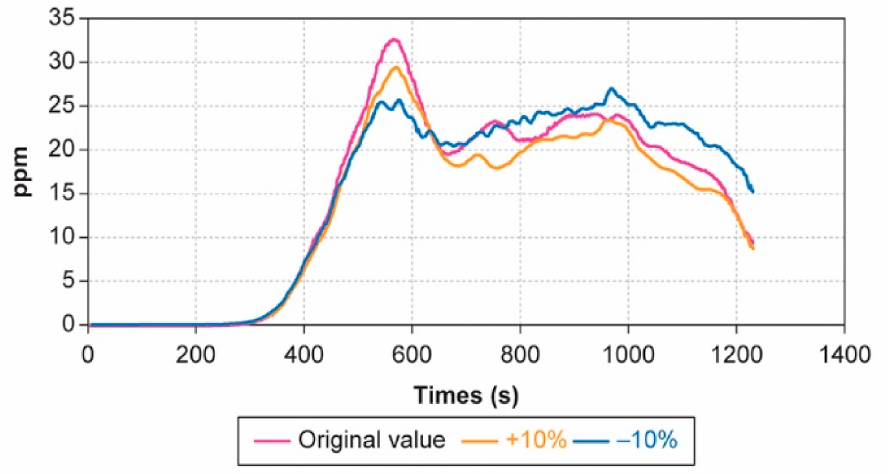
Figure 11. CO yield effects on CO concentration, 458 m downfield and 5.1 m above road